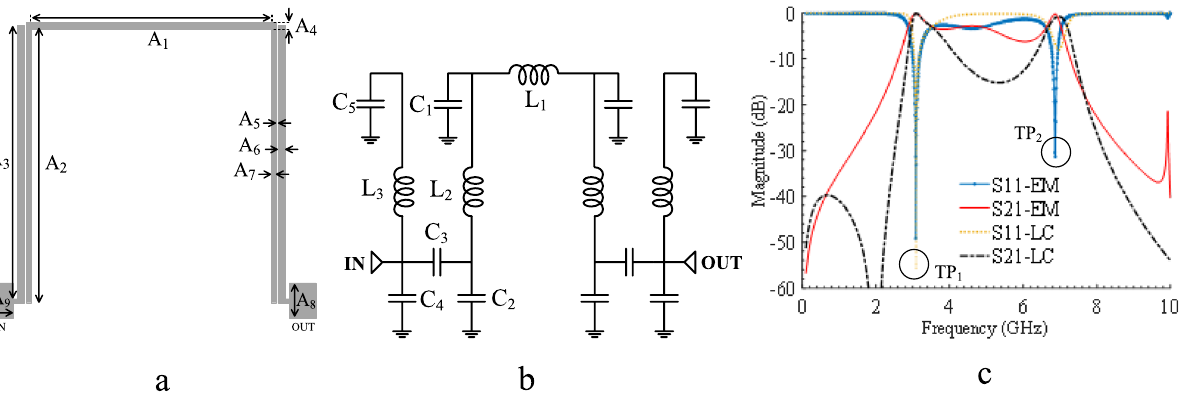
Figure 1. FR: ( a ) Layout, A 1 = 10.7, A 2 = 11.85, A 3 = 12, A 4 = 0.3, A 5 = 0.1, A 6 = 0.3, A 7 = 0.2, A 8 = 1.55 and A 9 = 1.17 (unit: mm), ( b ) LC model, ( c ) EM and LC